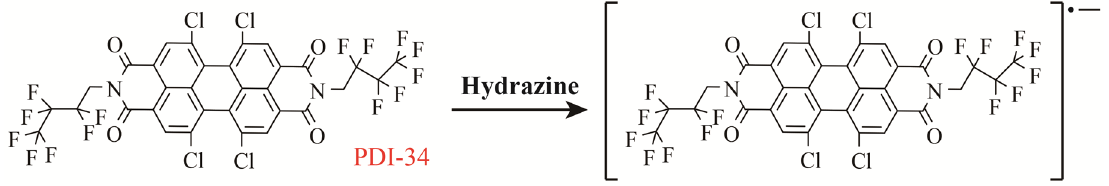
Figure 11. Molecular structures of neutral and one-electron reduced PDI-34.